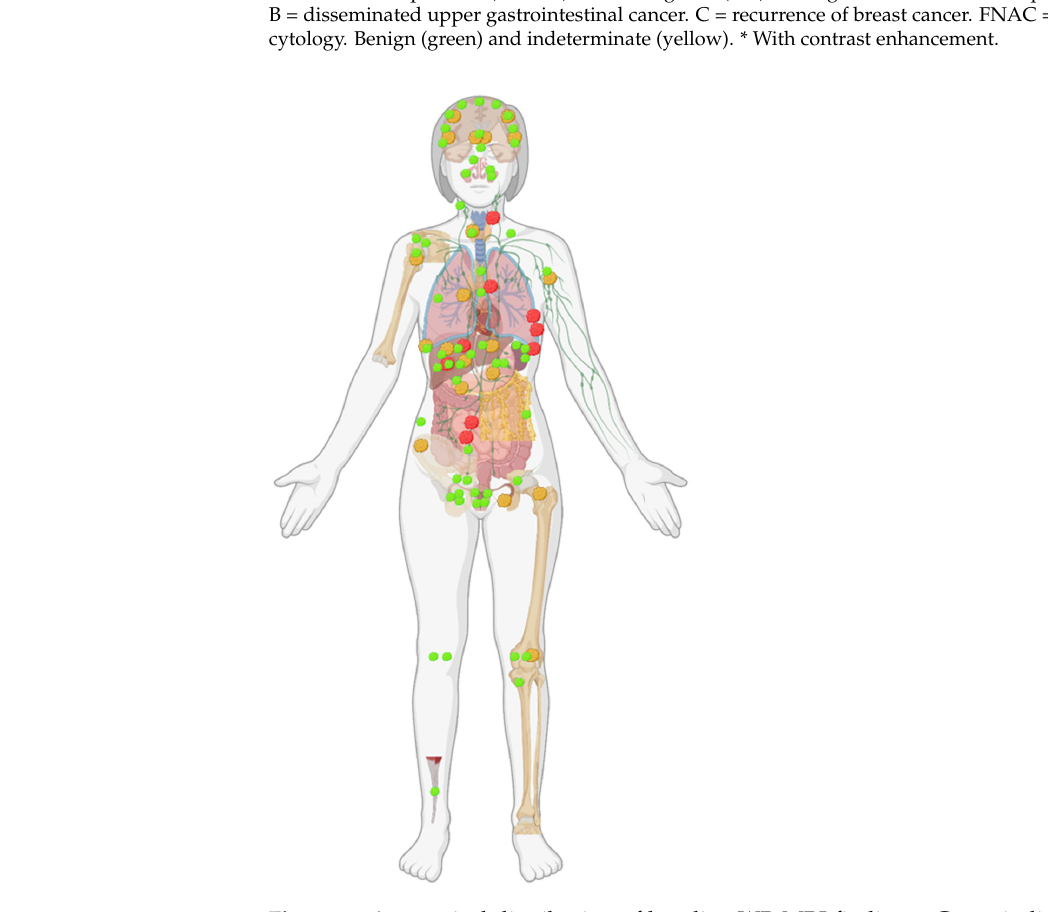
Figure 3. Anatomical distribution of baseline WB-MRI findings. Green indicating benign lesion, yel- yellow indeterminate, and red indicating malignant findings. Image created with low indeterminate, and red indicating malignant findings. Image created with BioRender.com (ac- cessed on 7 December 2021).